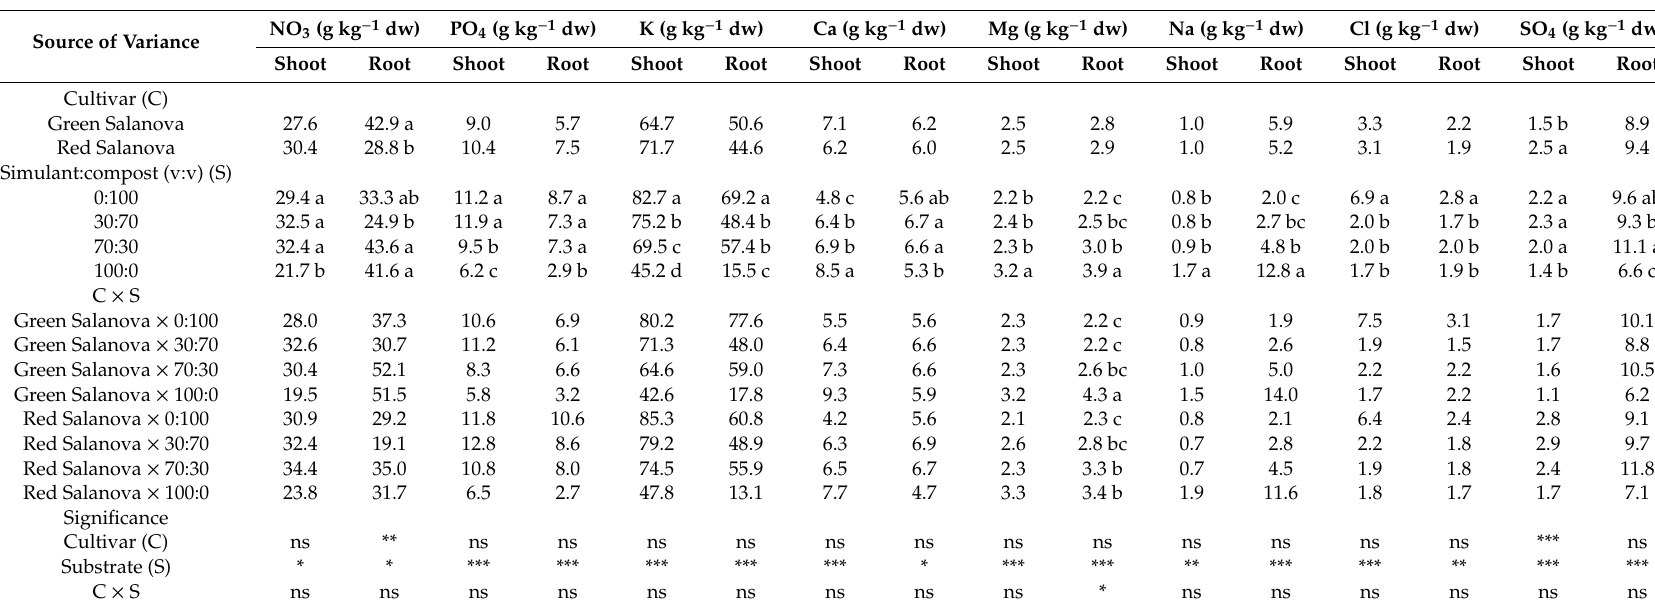
Table 1. Shoot and root mineral composition of green and red Salanova lettuce as influenced by substrate mixtures (four di ff erent rates of MMS-1 simulant:compost v:v). Source of Variance